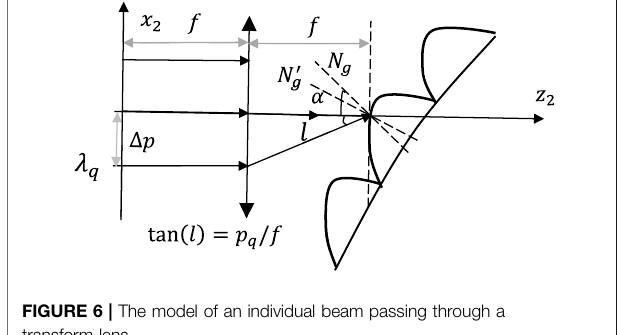
FIGURE 6 | The model of an individual beam passing through a transform